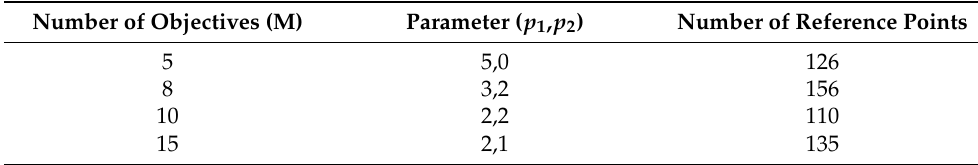
Table 2. The settings of each objective number and relative reference points number, where p 1 and p 2 denote the number of divisions on each objective in the boundary layer and inner layer. Number of Objectives (M) Parameter ( p 1 , p 2 ) Number of Reference Points 5 5,0 126 8 3,2 156 10 2,2 110 15 2,1